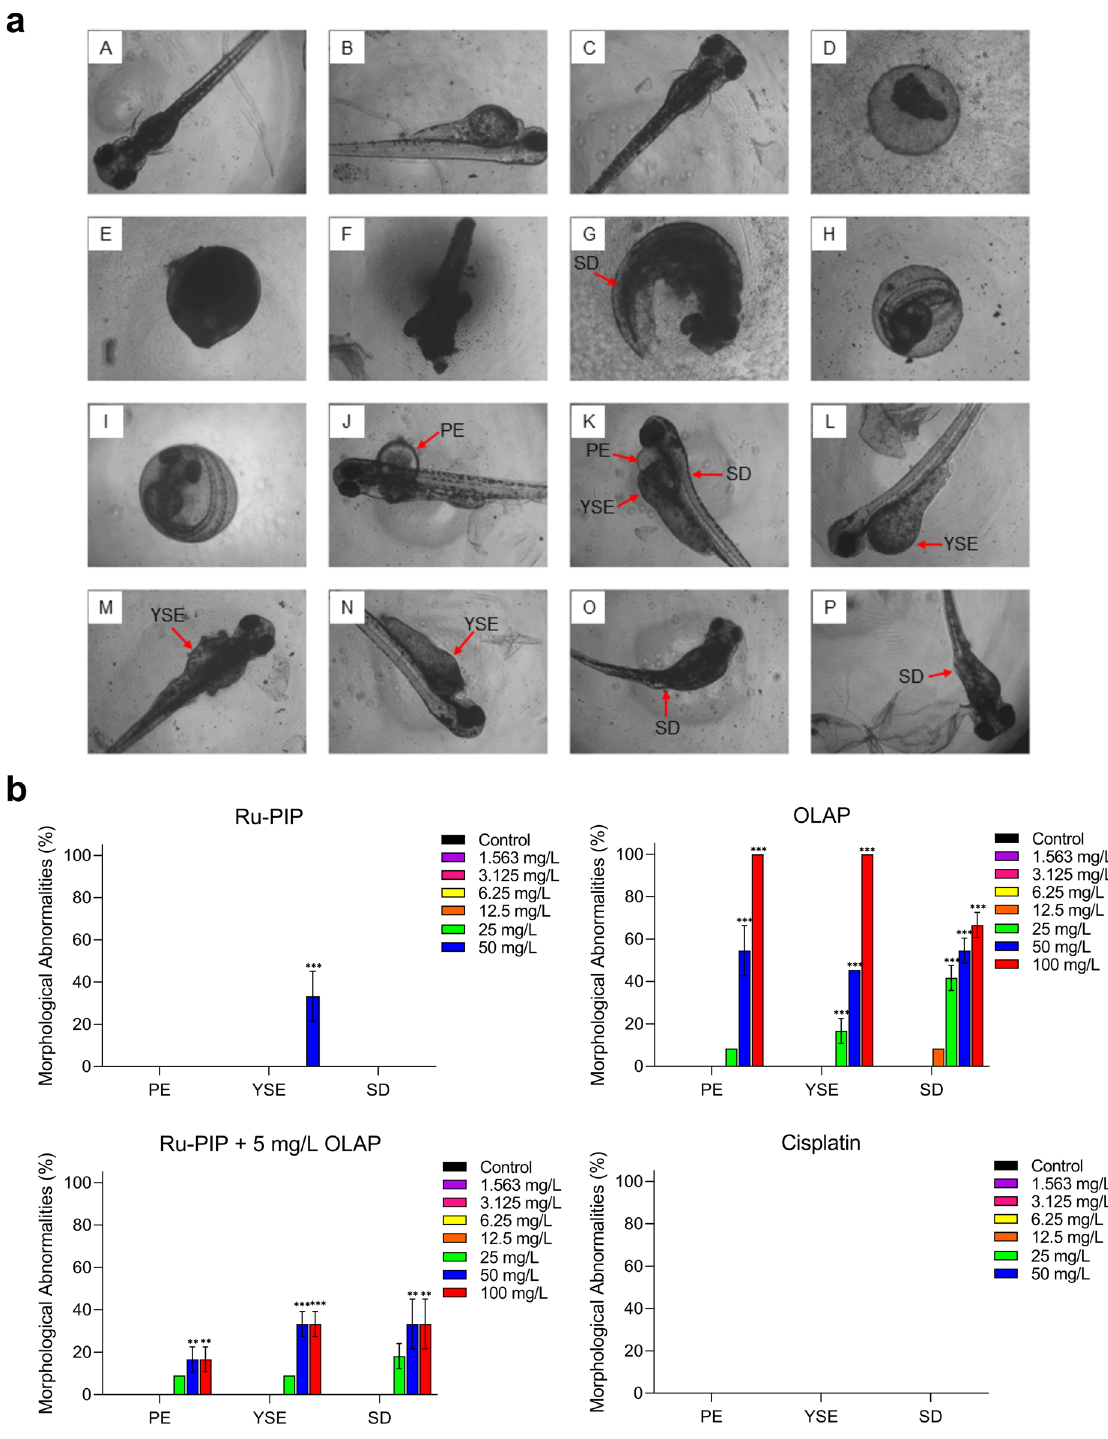
Figure 7. Morphological changes of the zebrafish embryos upon Ru-PIP or Olaparib treatment. ( a ) Morphological assessment of zebrafish embryonic development. (A–C) Normal zebrafish embryonic development at 96 hpf; (D–G) dead or coagulated embryos; (H–I) Non hatching; (J–P) morphological abnormalities; pericardial edema (PE), yolk sac edema (YSE), and spinal deformity (SD). ( b ) Morphological abnormalities of zebrafish embryos upon treatments with Ru-PIP, Olaparib, Ru-PIP/Olaparib combination and cisplatin at 96 hpf. Subtoxic concentration of Olaparib was used in the combination treatment (5 mg/L). Data expressed as percentage of morphological abnormalities observed of twenty-four embryos from two independent experiments. ** P < 0.01, *** P < 0.001 compared to control group by